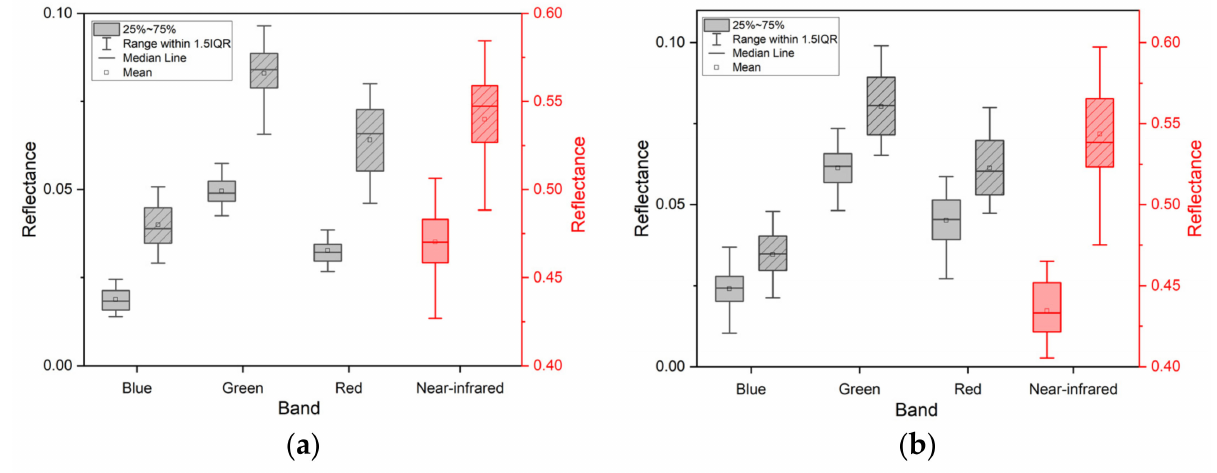
Figure 6. Box plots of spectral reflectance for lodged (shown with a slashed background) and non- lodged maize (shown without a slashed background) in ( a ) Zhaodong City and ( b ) Ningjiang District. The black color is for the blue, green, and red bands; the red color is for the near-infrared band. Table 2. The spectral reflectance variation in lodged maize compared to the non-lodged maize.